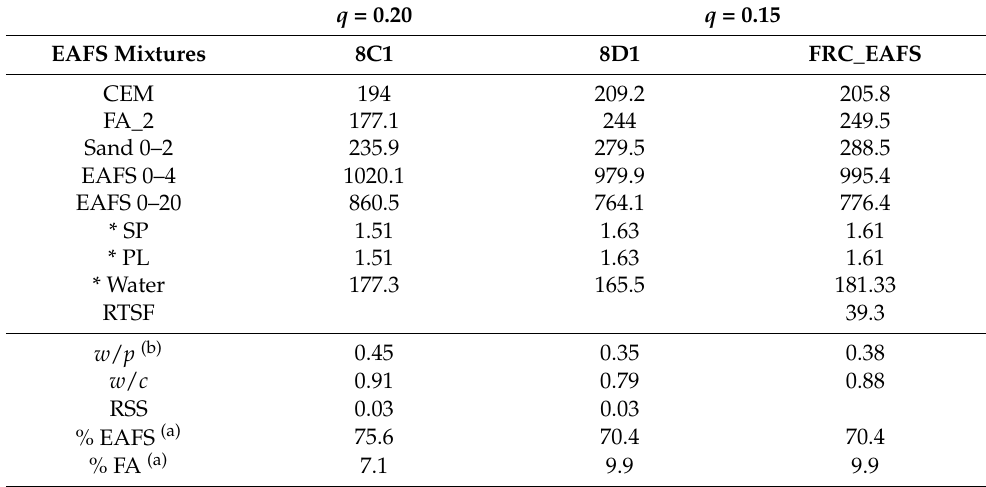
Table 6. Designed EAFS mixtures based on REF2 [kg/m 3 or * L/m 3 ]. q = 0.20